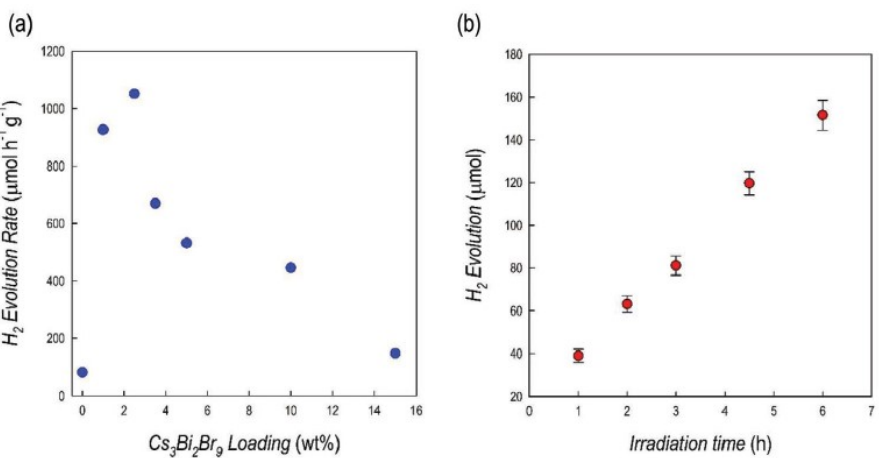
Figure 7. ( a ) Hydrogen evolution rates for Cs 3 Bi 2 Br 9 /g-C 3 N 4 composites (1 g L − 1 ) at different percentages of MHP loading in 10% v / v TEOA aqueous solution with Pt 3 wt%, under simulated solar light. ( b ) Hydrogen evolution profile over irradiation time for the 2.5% wt% Cs 3 Bi 2 Br 9 /g-C 3 N 4 composites, under simulated solar light [35].